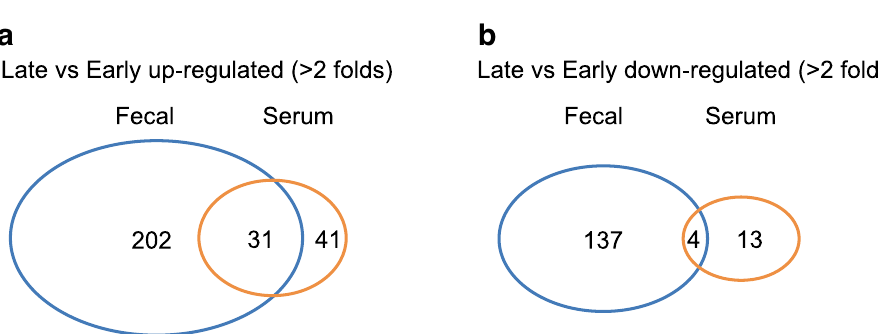
Figure 7. Overview of metabolomics. Venn diagram depicted the number of upregulated ( a , > 2 folds), down- regulated ( b , > 2 folds), and overlapping metabolites in fecal and serum samples between late PMA (> 30 weeks) and early PMA (< 30 weeks). Blue circles, metabolites from fecal samples. Red circles, metabolites from serum